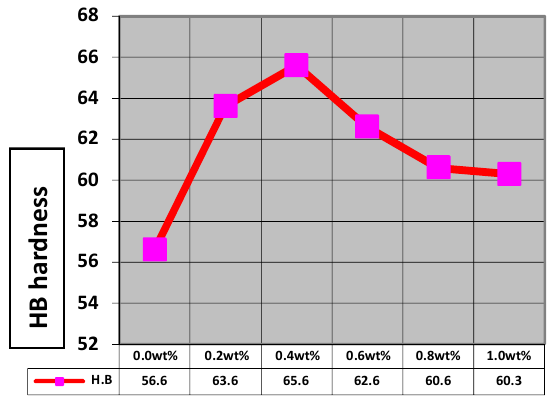
Fig. 1. HB Average Hardness against AL 2 O 3 wt.%.